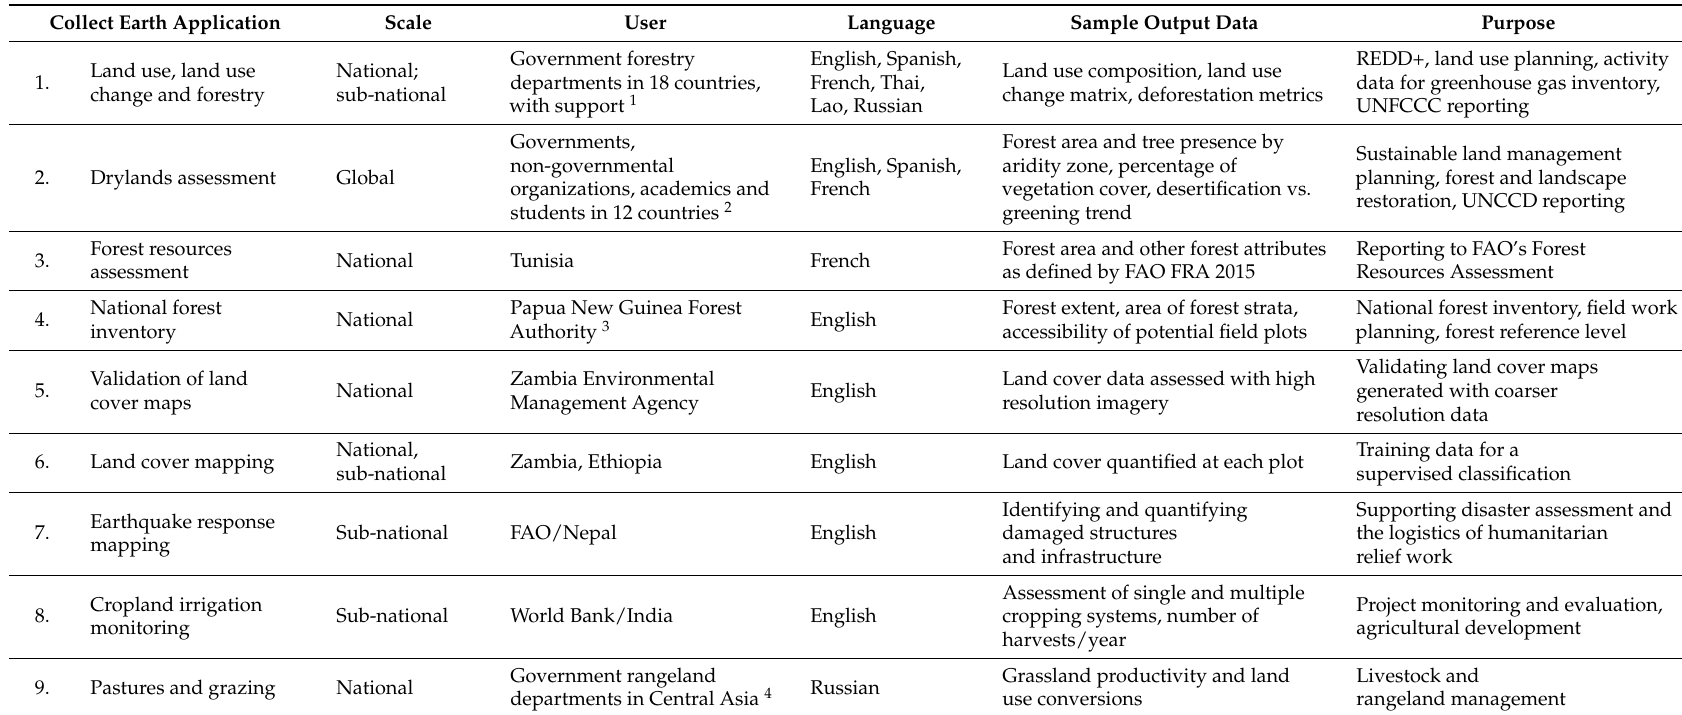
Table 2. Collect Earth customizations and